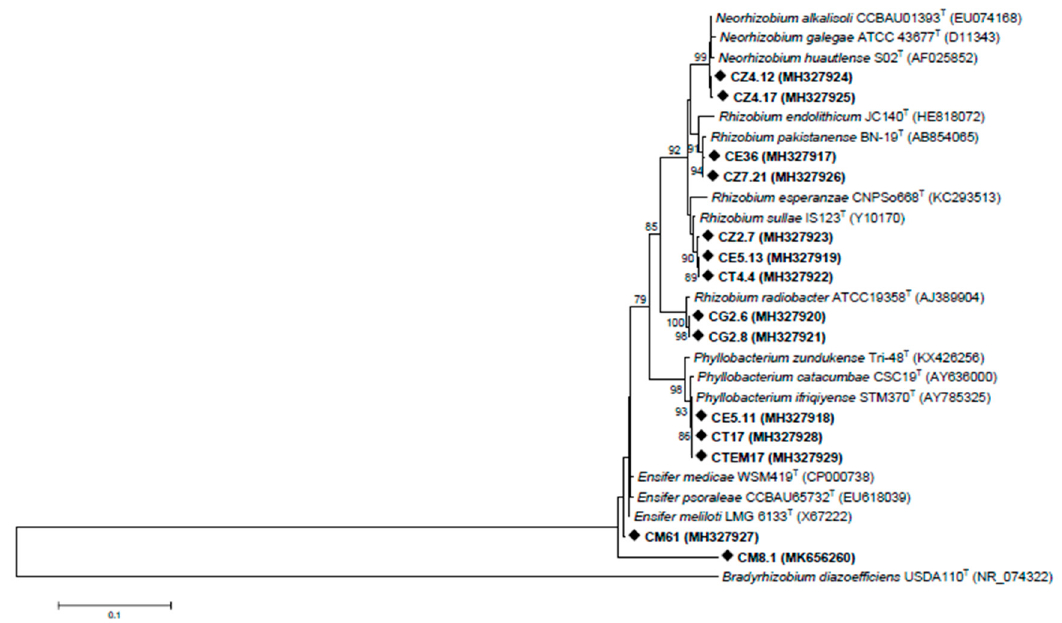
Figure 1. Neighbour-joining phylogenetic tree based on the 16S rRNA gene of representative nodule-inducing strains isolated from nodules of Calicotome villosa . Bootstrap confidence levels were derived from 1000 replications, and those greater than 75% are indicated at the internodes. Scale bar = 0.1 nucleotide divergence.